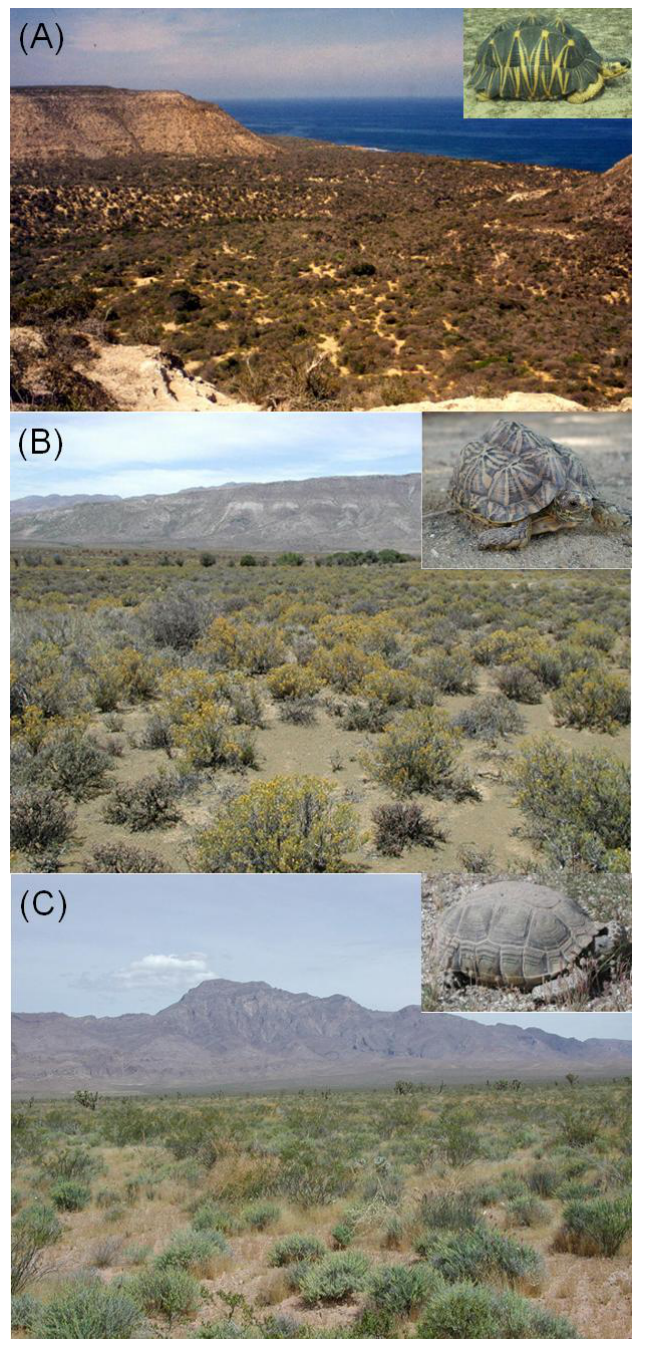
Fig. 2. Photographs of the tortoises (insets) and tortoise habitat of the three study regions. (A) Radiated tortoise, dry spiny forest at Cap Sainte Marie, Madagascar. (B) Tent tortoise, Karoo near Prince Albert, South Africa. (C) Desert tortoise, Mojave Desert, California, USA. Photos: T. E. J.